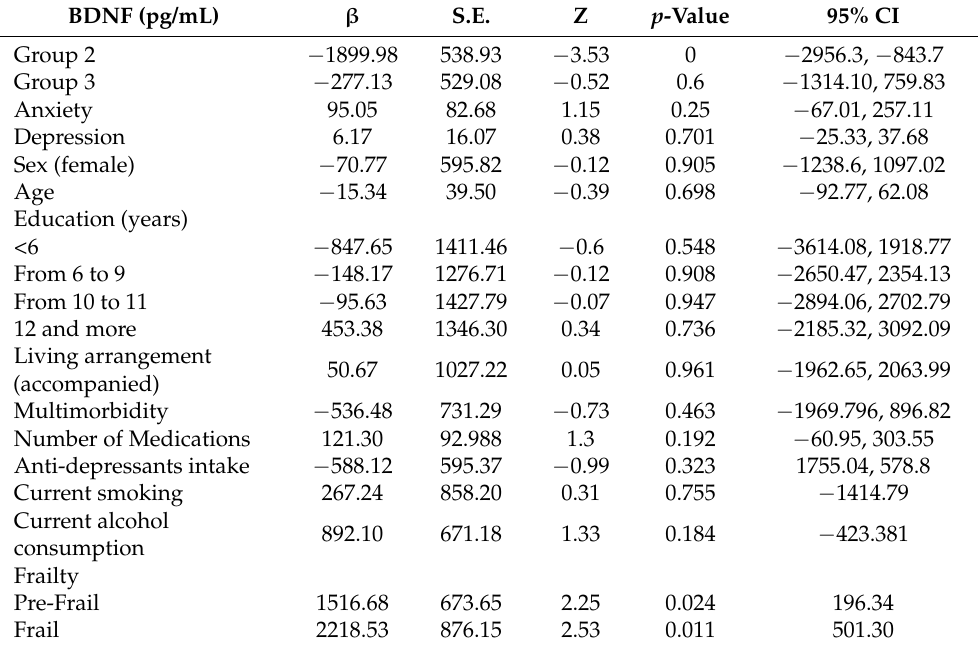
Table 3. Adjusted linear regression model for the association between variables separately considering insomnia and cognitive decline on BDNF concentration in